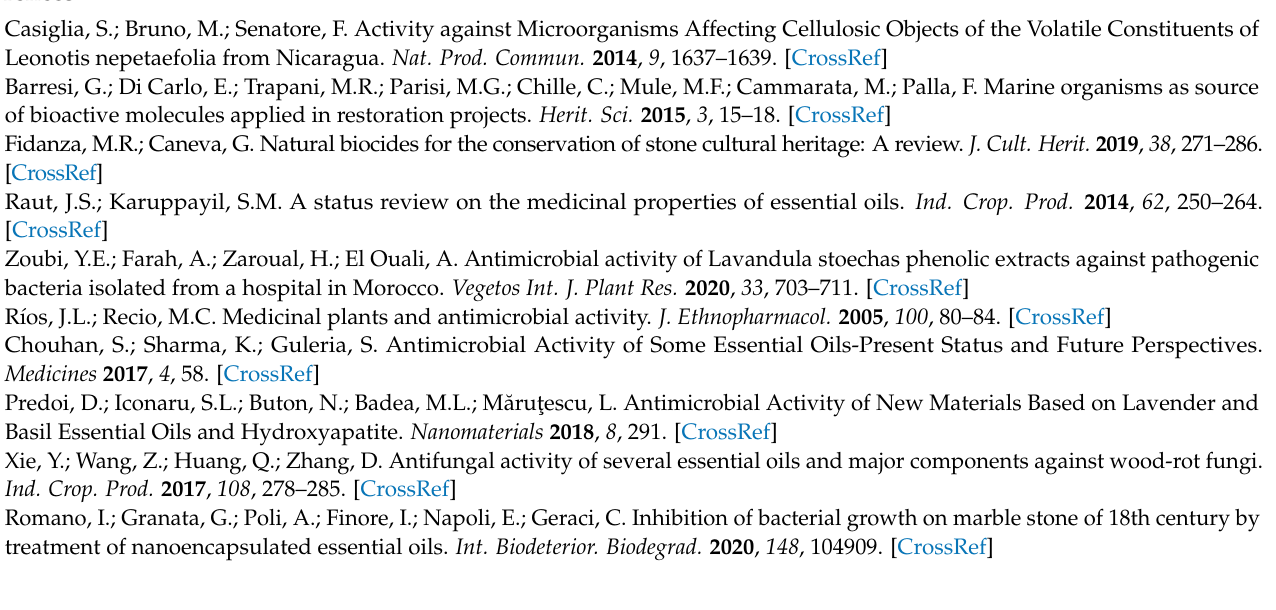
Table S4: Clustering of bacterial strains isolated from canvas painting and their phylogenetic identifi- cation by 16S rRNA gene sequencing; Table S5: Clusterization of fungal strains isolated from canvas painting and their phylogenetic identification by ITS gene sequencing; Figure S1: Clusterization and relative abundance of bacterial (a) and fungal (b)